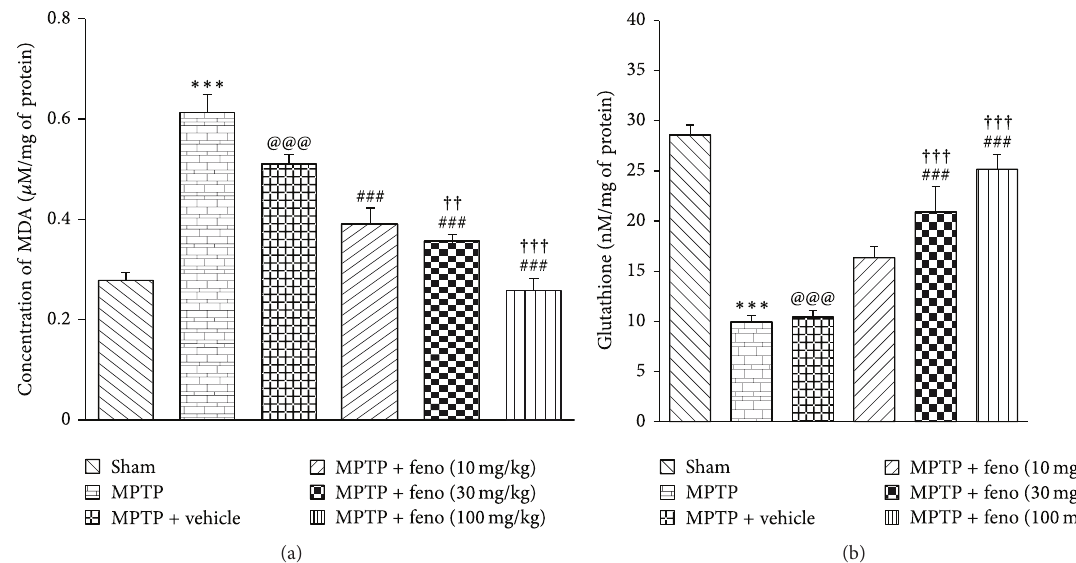
Figure 2: (a) Effect of fenofibrate on MDA and (b) GSH level in different groups. ∗∗∗ 𝑃 < 0.001 MPTP versus sham, ### 𝑃 < 0.001 MPTP versus feno 10mg/kg, feno 30 mg/kg and feno 100mg/kg treated groups, @@@ 𝑃 < 0.001 MPTP + vehicle versus sham and ††† 𝑃 < 0.001 MPTP + vehicle versus feno 100mg/kg group, †† 𝑃 < 0.01 MPTP + vehicle versus feno 30mg/kg treated group. All readings are expressed as mean ± SEM ( 𝑛 = 8 to 12).